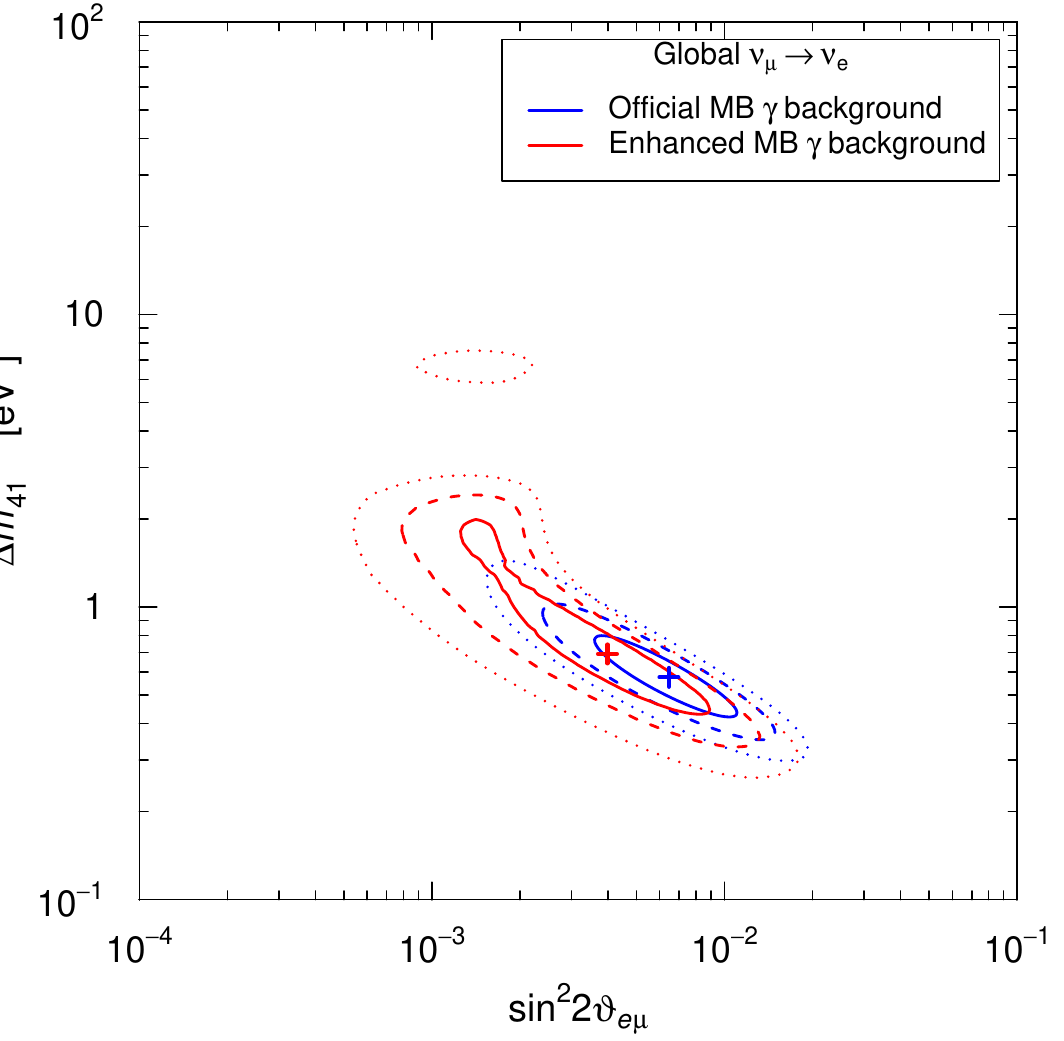
Figure 4 . Contours enclosing 1 σ (solid), 2 σ (dashed), and 3 σ (dotted) allowed regions in the ( sin 2 2 ϑ eµ , ∆ m 2 ) plane obtained from the global analysis of the data of ( − ) ν µ → ( − ) ν e oscillation exper- 41 iments without (blue) and with (red) the enhanced single- γ background in the analysis of Mini- BooNE